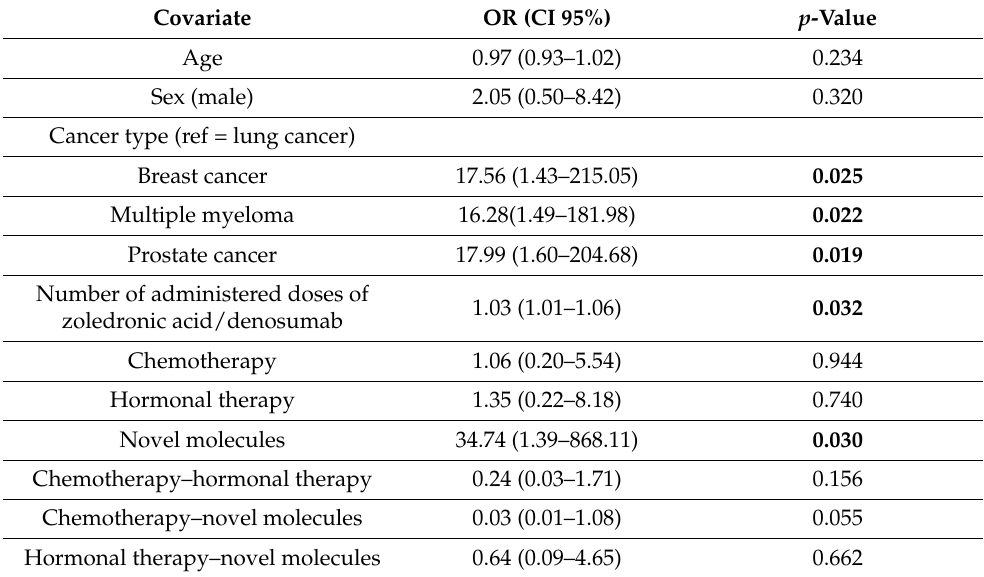
Table 4. Multiple logistic regression model to identify independent predictors of risk of MRONJ in cancer